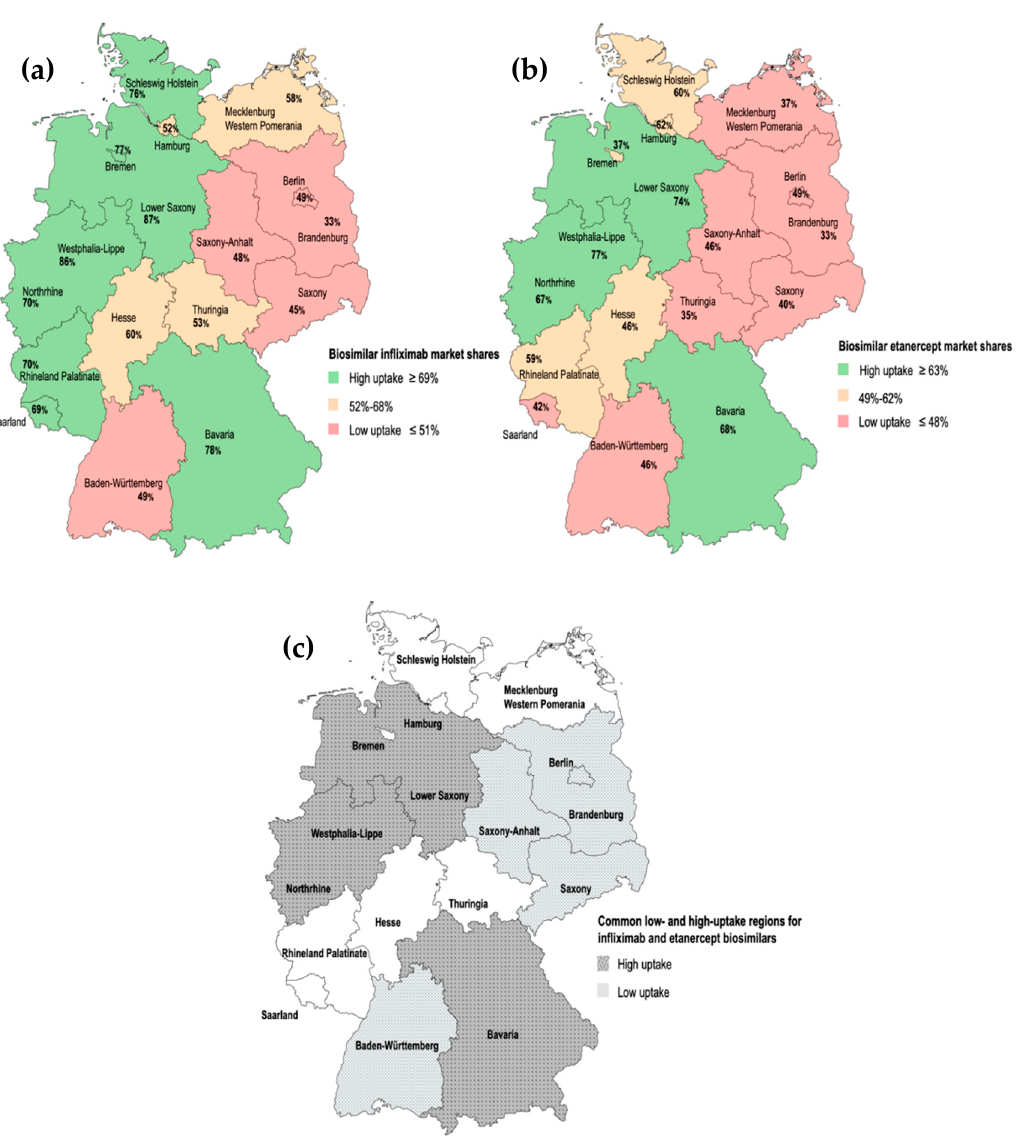
Figure 5. ( a ) Market shares (%) of biosimilar infliximab in Q4 2018. ( b ) Market shares (%) of biosimilar etanercept in Q4 2018. ( c ) Low- and high-uptake PA regions which are common for infliximab and etanercept biosimilars in Q4 2018. The dotted pattern refers to regions with high biosimilar uptake for both infliximab and etanercept. The crossed pattern refers to regions with low biosimilar uptake for both infliximab and etanercept. The map templates were extracted from mapchart.net.